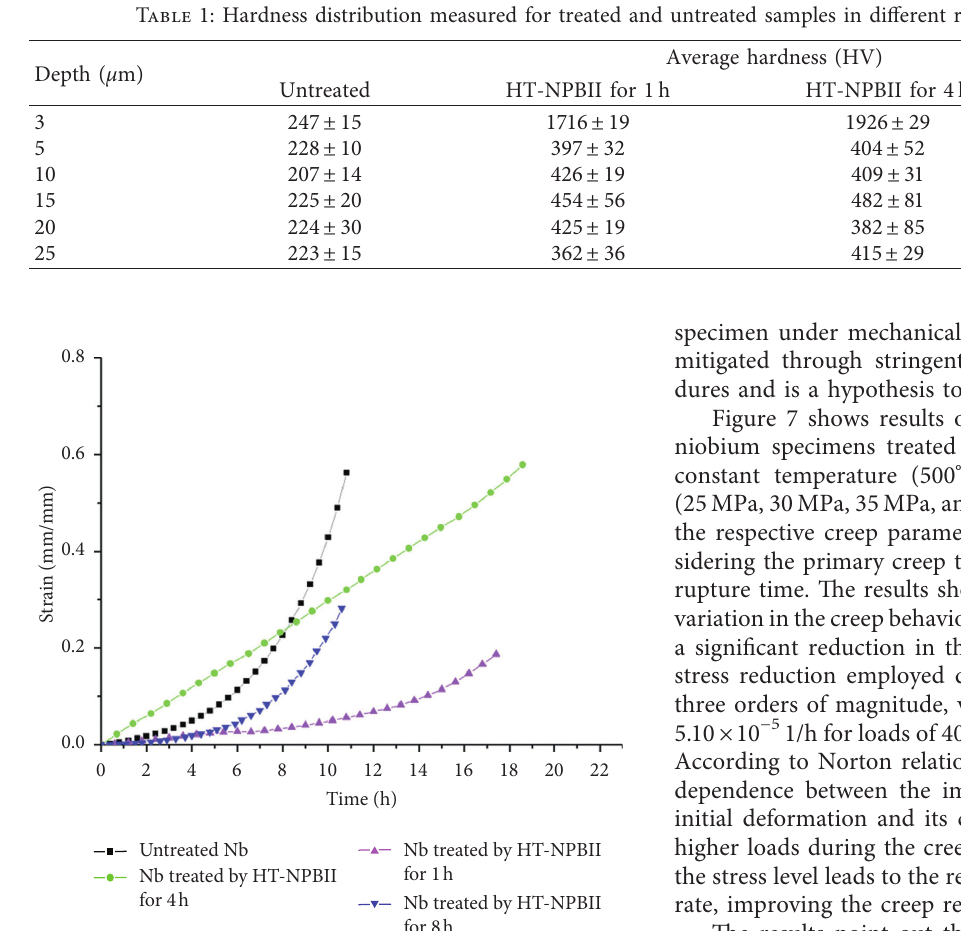
Figure 6: Typical creep curves of niobium treated by HT-NPBII submitted to creep tests at 500 ° C and